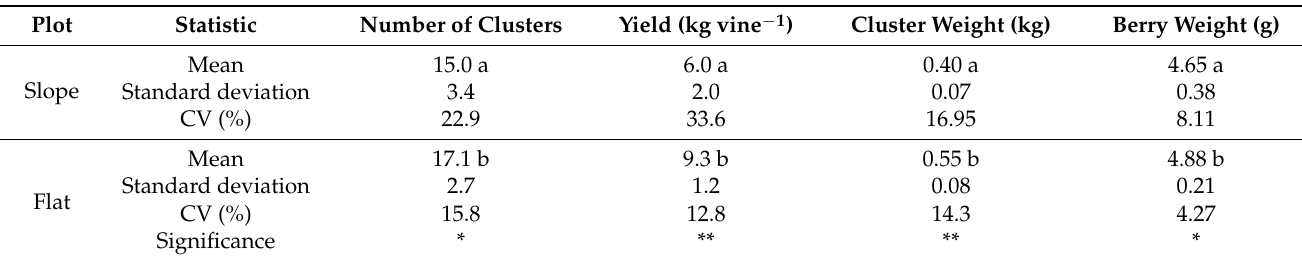
Table 2. Descriptive statistics and analysis of variance (ANOVA) for the yield and yield components of the slope and flat plots under study.